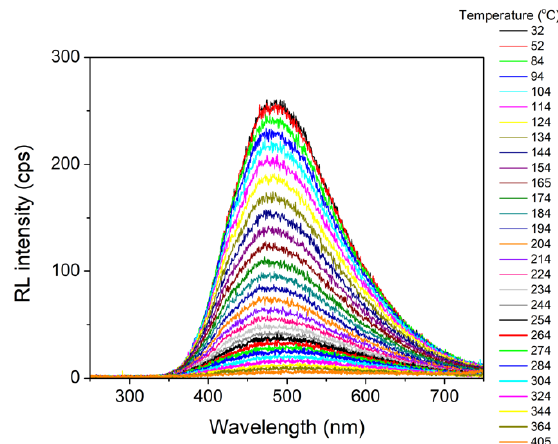
Figure 5. Optical images of Rb 4 Ge 5 O 9 F 6 :Nb crystals in the absence of X-rays ( left ) and of the same crystals scintillating under X-ray excitation ( right ).